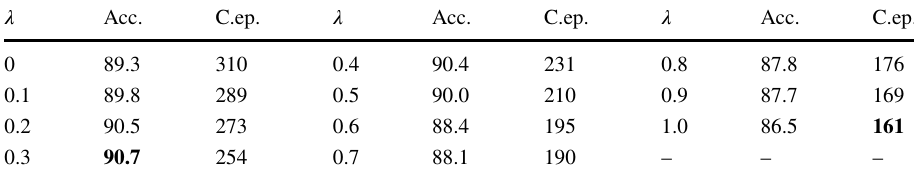
Table 4 Effect of the sparsity parameter 𝜆 on accuracy (%) and convergence epoch (C.ep.) for the NTU